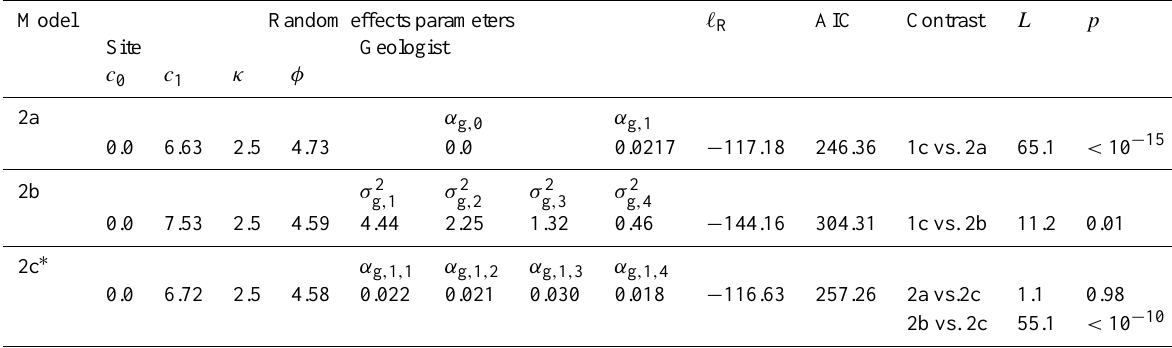
Table 5. Model 2 and variants, parameter estimates and inferences.